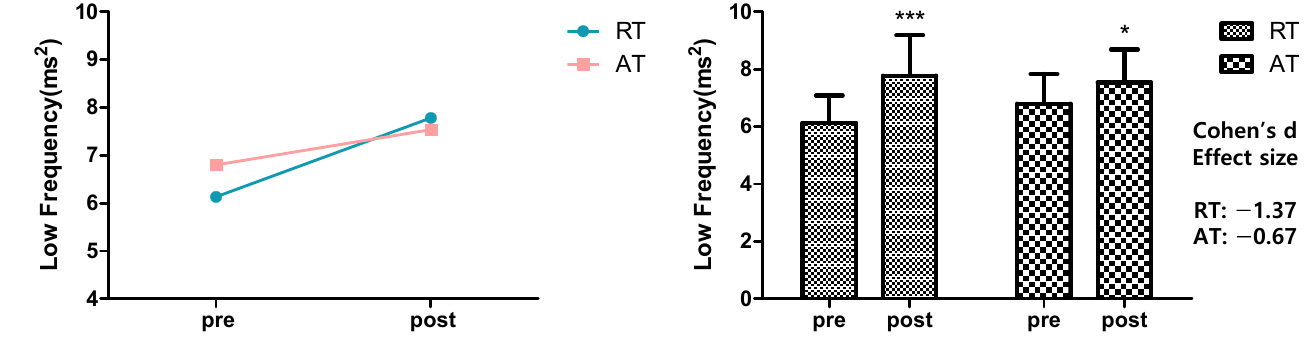
Figure 2. Effects of 12-week resistance training and aerobic training on Low Frequency. LF significantly increased in the RT (*** p < 0.001), AT (* p < 0.05) compared with the pre-test. However, LF showed no significant interaction effect. The data presented were mean ± SD. * p < 0.05, *** p < 0.001; before and after significant. Effect size range: |0.20| ≤ small < |0.50| < medium < |0.80| ≤ large. RT = resistance training, AT = aerobic training, LF = low frequency.